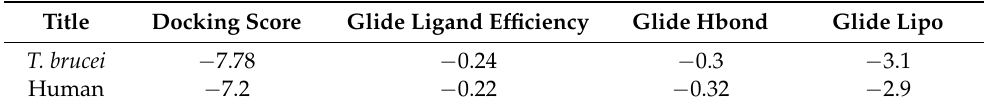
Table 4. The docking score and binding parameters for raltitrexed with human (PDB ID 1DRF) or